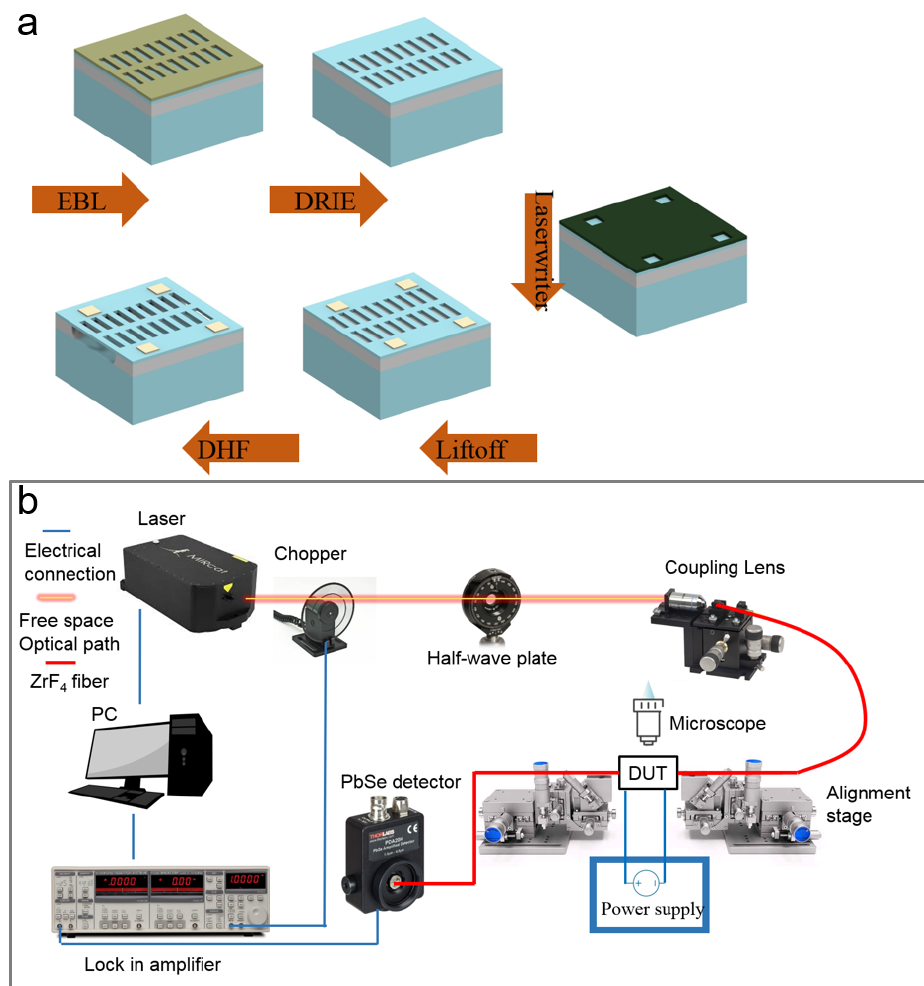
Figure 4. ( a ) Fabrication process flow. ( b ) Experimental setup.